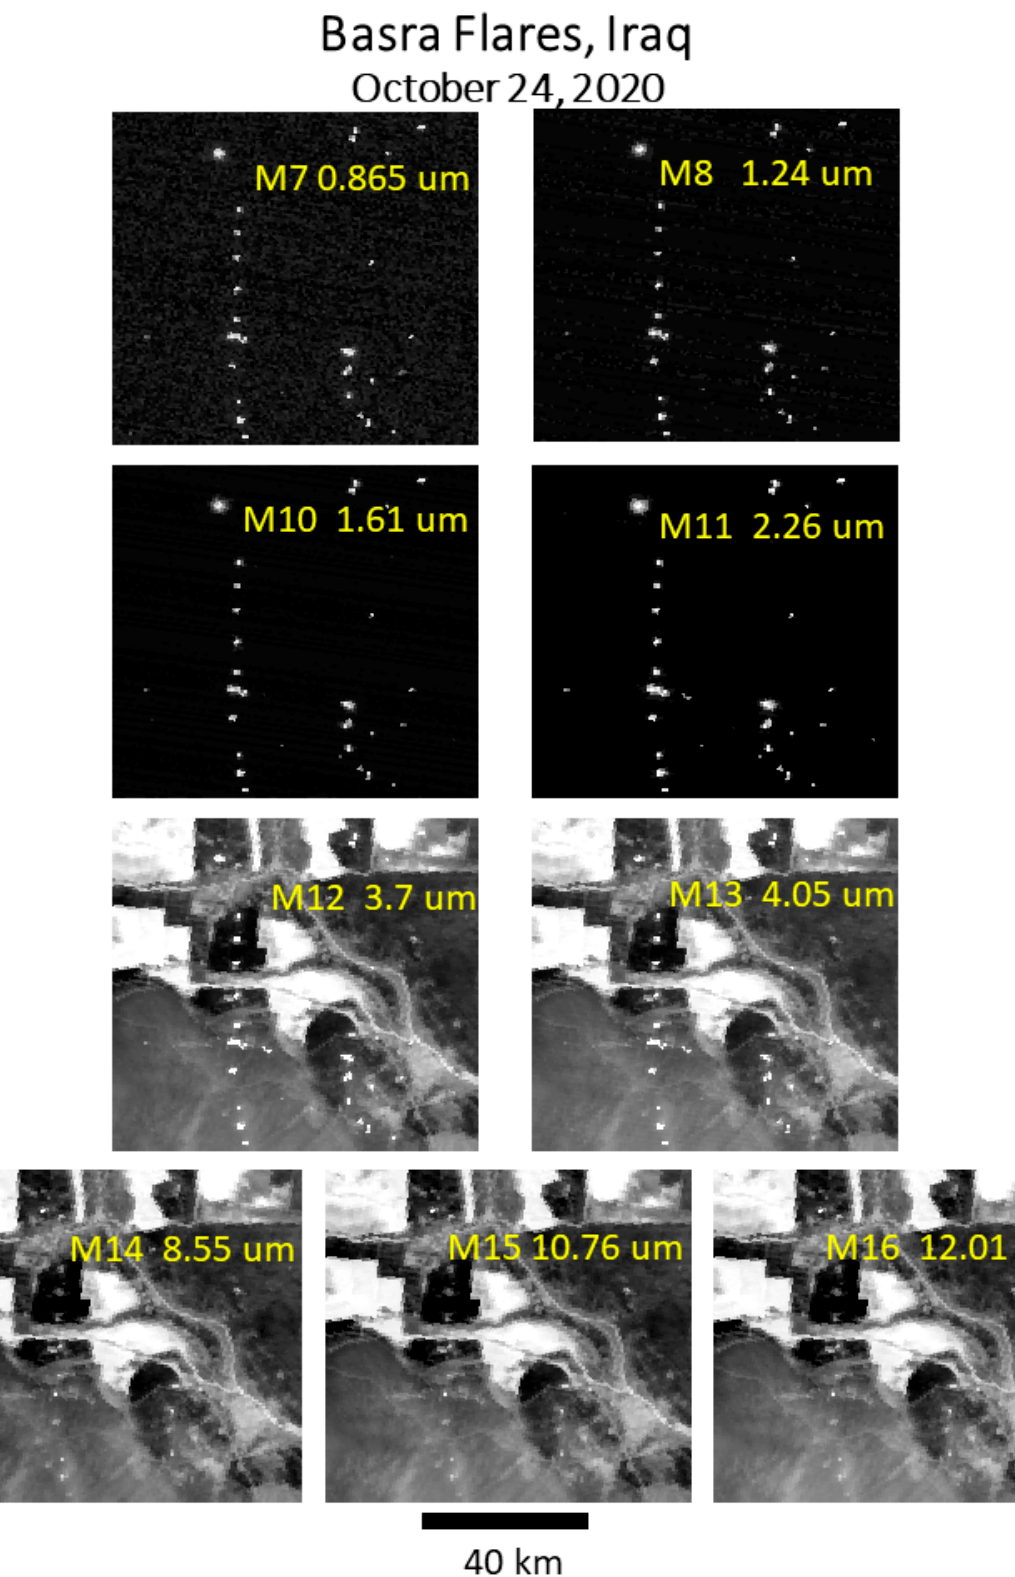
Figure 7. The Basra gas flare study area.